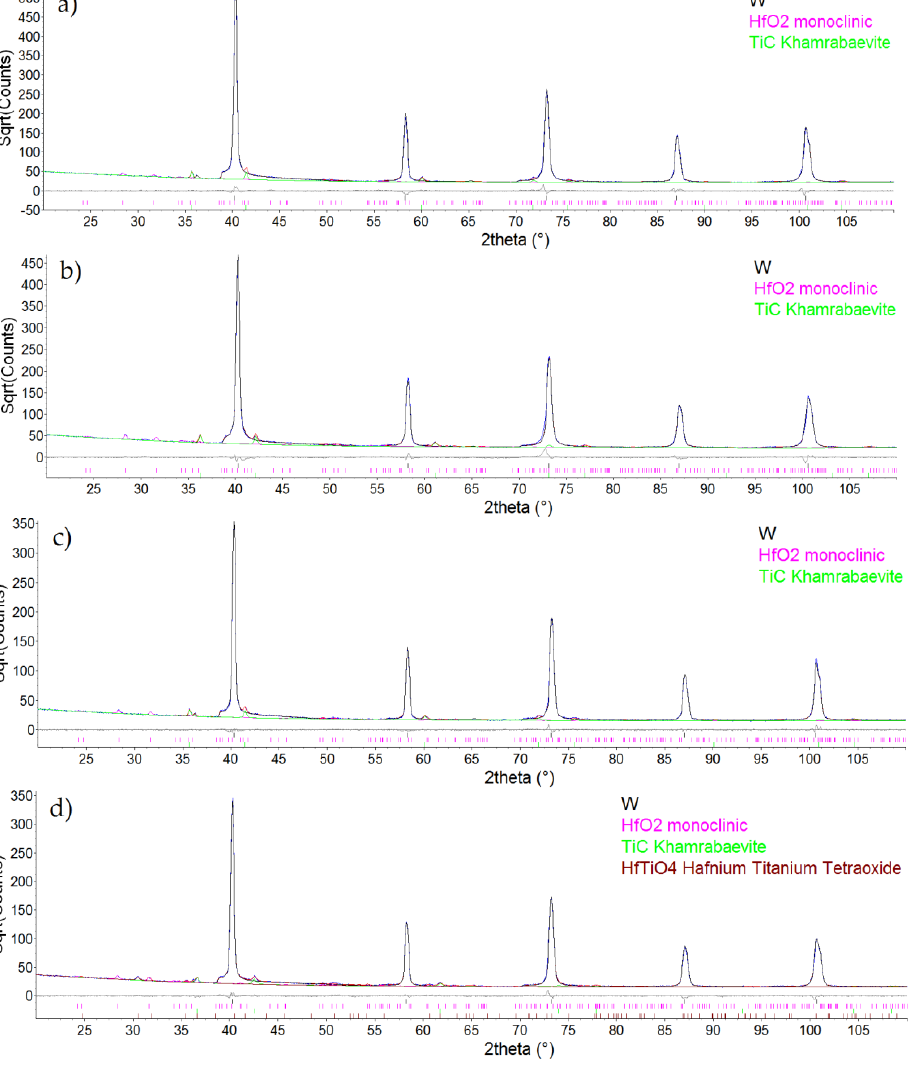
Figure 1. X-ray diffraction patterns with Rietveld refinement analysis for sintered